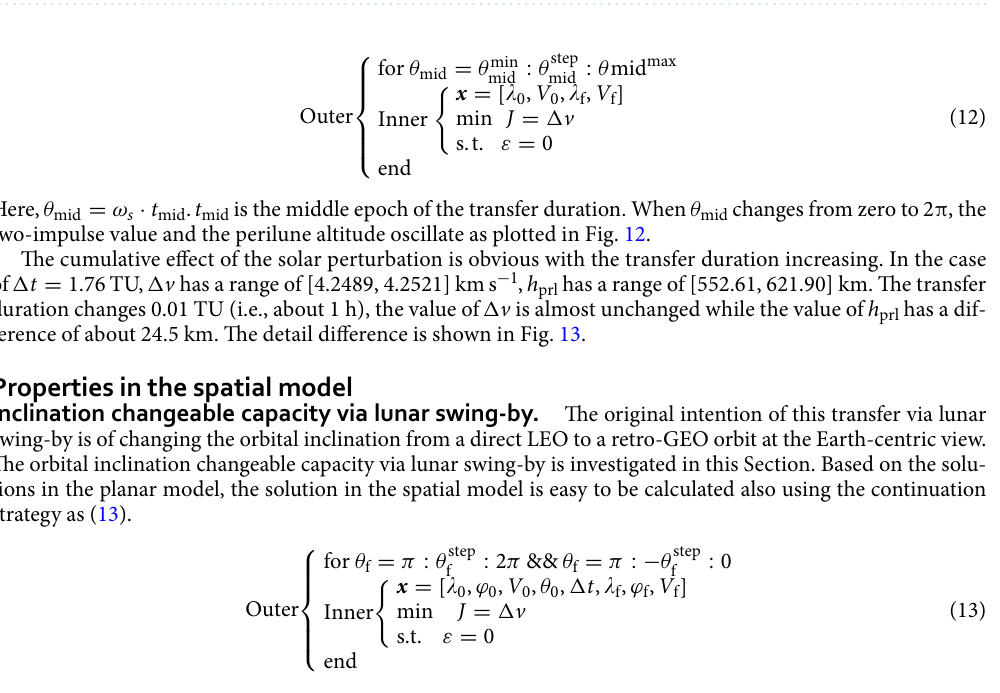
Figure 13. Two-impulse value and perilune altitude oscillate with different transfer